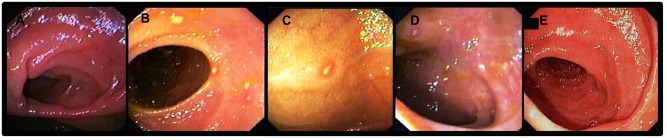
Endoscopy (neo-terminal ileum) after a total of 30 months of therapy with infliximab 3 mg/Kg.Rutgeerts scores were identical to baseline (baseline: one year of treatment with infliximab 3 mg/Kg): 0,1,1,1,0 in patients #1,#2,#3,#4,#5 listed in Table 1, respectively (A-E).